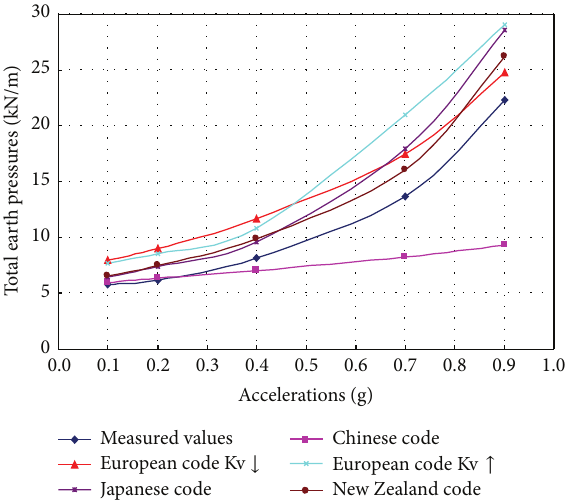
Figure 14: Comparison of measured earth pressures and theoretical results by codes for soil foundation.